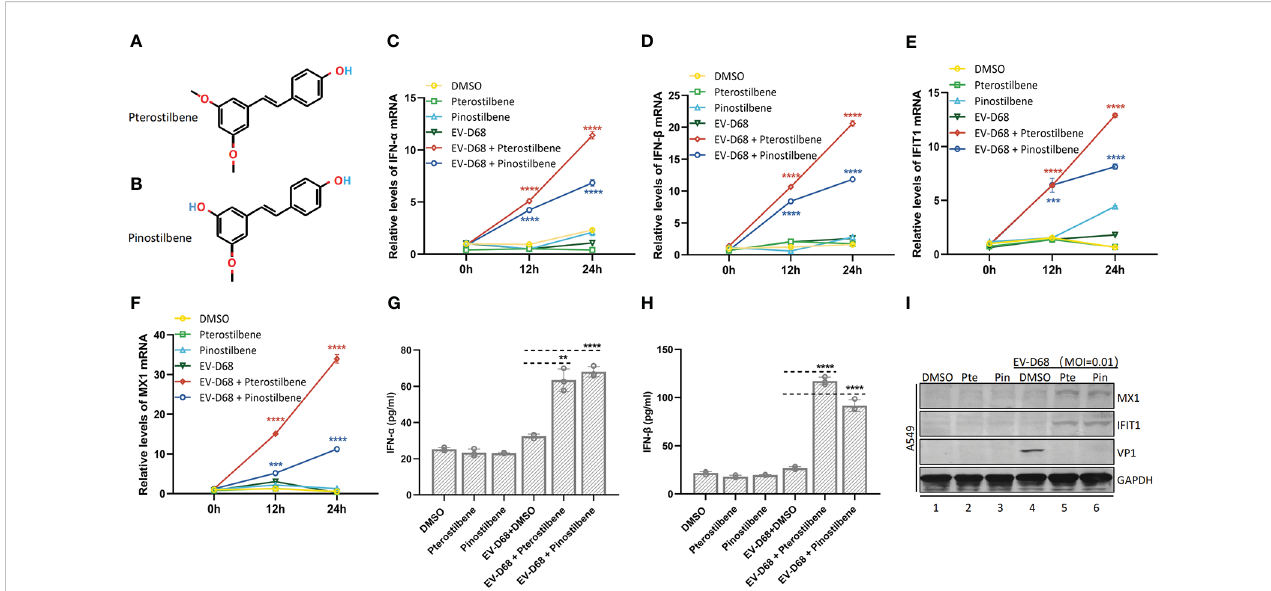
FIGURE 1 Pterostilbene (Pte) and pinostilbene (Pin) enhance EV-D68-induced innate immune responses. (A) Structure of Pte (molecular formula: C 16 H 16 O 3 ). (C – F) Gene expression of IFN- a (C) , IFN- b (D) , IFIT1 (E) , and MX1 (F) , respectively, as indicators of (B) Structure of Pin (molecular formula: C 15 H 14 O 3 ). virus-stimulated innate immune response. The mRNA was quanti fi ed by qRT-PCR at 0, 12, and 24 h post-infection. (G, H) Detection of IFN- a and IFN- b protein concentrations in supernatants by ELISA. (I) Detection of MX1 and IFIT1 in cells by Immunoblotting. Supernatants or cells were collected 24 h post-infection or mock-infection. Error bars indicate the standard deviation (**, P < 0.01; ***, P < 0.001; ****, P < 0.0001). EV-D68, Enterovirus D68; IFN, interferon; IFIT1, interferon-induced protein with tetratricopeptide repeats 1; MX1, MX dynamin-like GTPase 1; qRT-PCR, quantitative reverse transcription polymerase